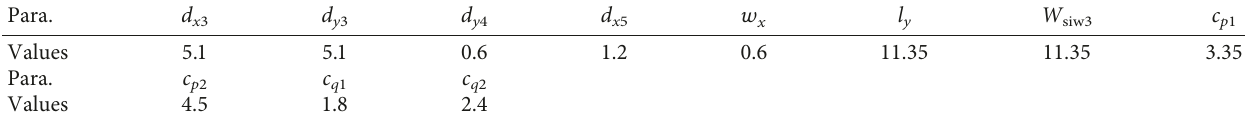
Figure 16: Simulated S-parameters of SMA-to-SIW. Table 4: Dimensions of the feeding structure (unit: